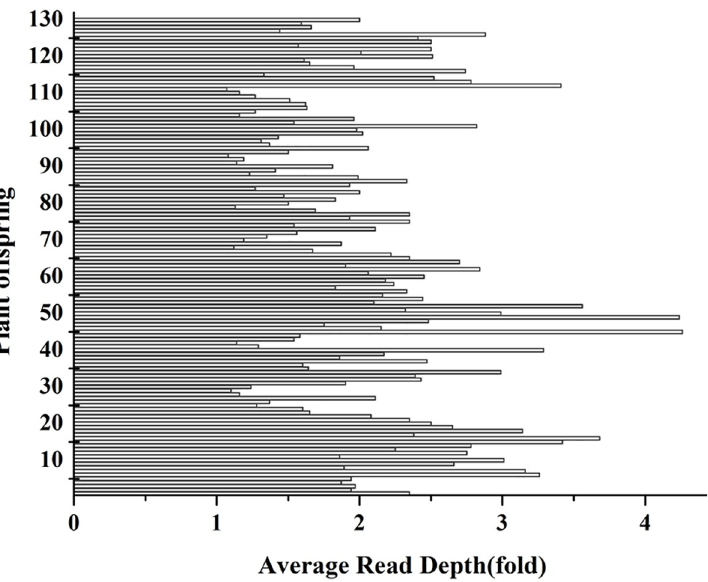
Fig 3. Sequencing depth distribution of 130 hybrid